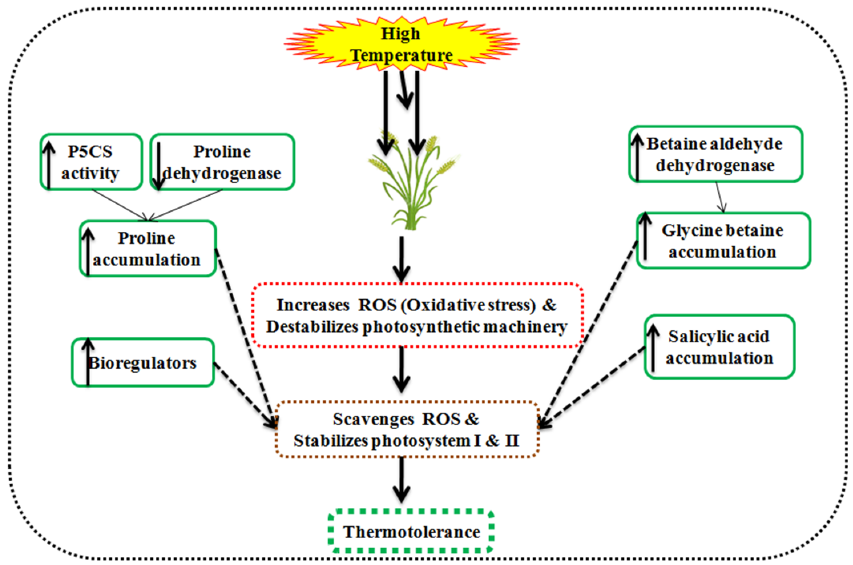
Figure 7. Schematic illustration of osmolytes associated with thermotolerance in wheat. A high temperature of 30–35 °C discolorizes the chlorophyll, beta-carotene, and dam- ages the photochemical activity. Glycine betaine accumulates in the chloroplast of leaves and stabilizes PS-II, reaction centers in the thylakoid membrane [120,121], Rubisco en- zyme, and inhibits the ROS production [122]. It adjusts the osmotic pressure, ameliorate antioxidant enzymes activity, and photosynthesis under high temperature in wheat [123]. Salicylic acid acts as a phenolic hormone in plants and is responsible for osmoregulation, scavenges ROS, and maintains the photosynthesis in wheat [124]. It also triggers the os- molytes synthesis viz., glycine betaine, proline, and sugars under heat stress conditions [125–127]. Proline accumulation is determined by the proline dehydrogenase activity and Δ 1- pyrroline-5-carboxylate synthetase/reductase (P5CS) [128]. High temperature increases the P5CS and decreases proline dehydrogenase in tolerant wheat seedlings. Proline dehy- drogenase catalyzes the proline degeneration in mitochondria. However, glutamate acts as a precursor in the presence of P5CS1 for the proline synthesis and accumulates in plant under heat stress conditions [129,130]. The proline content is directly linked to a high tem- perature of 35–40 °C and ameliorates the defense mechanism in wheat seedlings [131]. A high temperature of 35 °C than 25 °C accumulates a higher proline content (up to 200%) and improves the photosynthetic efficiency and yield [132]. Bioregulators upregulate the antioxidant defense mechanism and maintains the PS- II under high temperature. Foliar application during the grain filling period and seed priming with a 6.6 mM solution of thiourea intensifies the antioxidant enzyme activity, chlorophyll content, total soluble protein, amino acid, and grain weight in wheat [133]. Foliar application of 50 ppm dithiothreitol also ameliorates the adverse effect of high tem- perature in wheat [134].